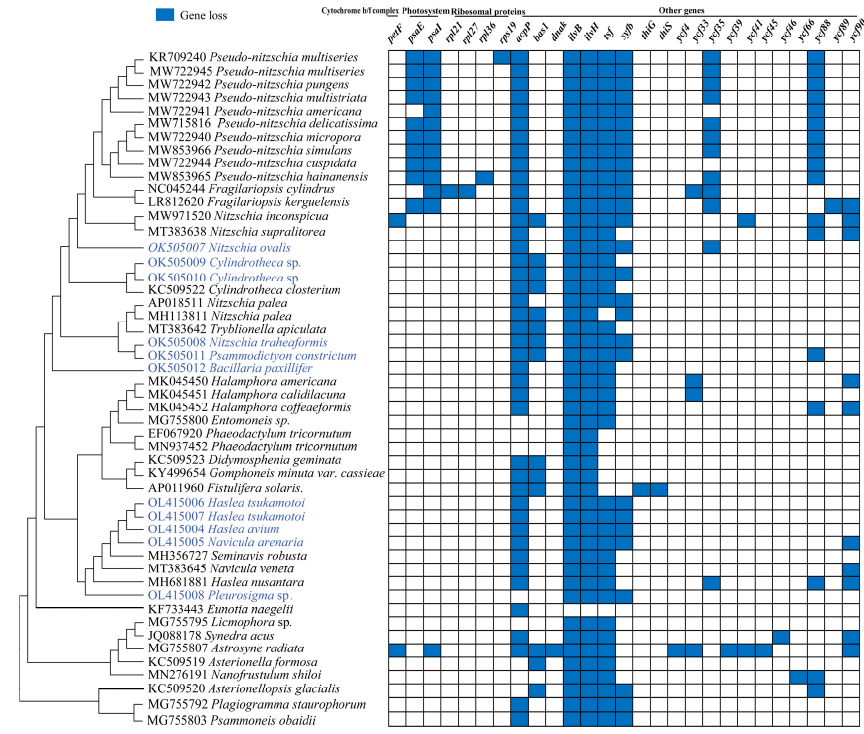
Figure 3. Gene losses in diatom cpDNAs. The matrix shows the presence (empty) and absence (blue) of 27 genes among the cpDNAs of Bacillariophyceae. 3.3. Plasticity of the Inverted Repeat Regions in Bacillariophyceae The inverted repeat (IR) region in Bacillariophyceae varies in length by nearly five- fold, from ~7 kb in Bacillaria paxillifer to ~38 kb in Fragilariopsis kerguelensis (Figure 4). All IR regions contained a conservative gene block ( rns - trnI - trnA - rnl - rrn5 ) except for that of Nitzschia inconspicua , which contained an extra-unidentified gene orf134 inserted into this gene cluster ( rns - orf134 - trnI - trnA - rnl - rrn5 ). In some cases, IR expansions have resulted in the duplication of a large number of genes. The IR expansion of Fragilariopsis kerguelensis resulted in the duplication of over a dozen PCGs (Figure 4).